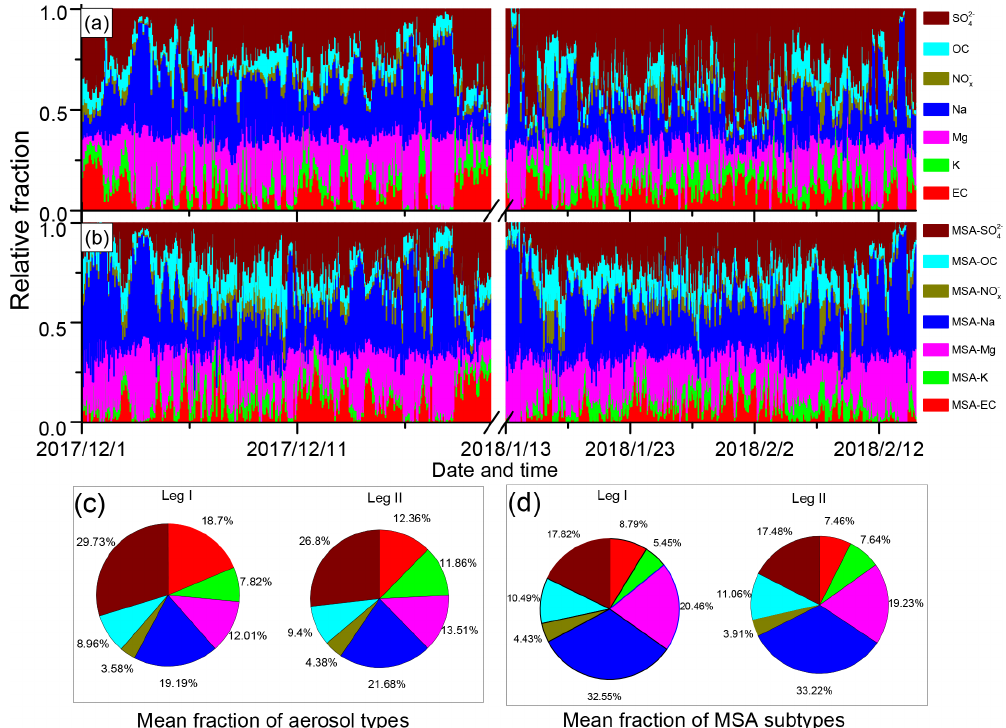
Figure 4. Relative fractions of different particle types during leg I and leg II. (a) Relative fractions of different particle types; (b) relative fractions of MSA subtype particles; (c) average fractions of different particle types during leg I and leg II; and (d) average fractions of MSA subtype particles during leg I and leg